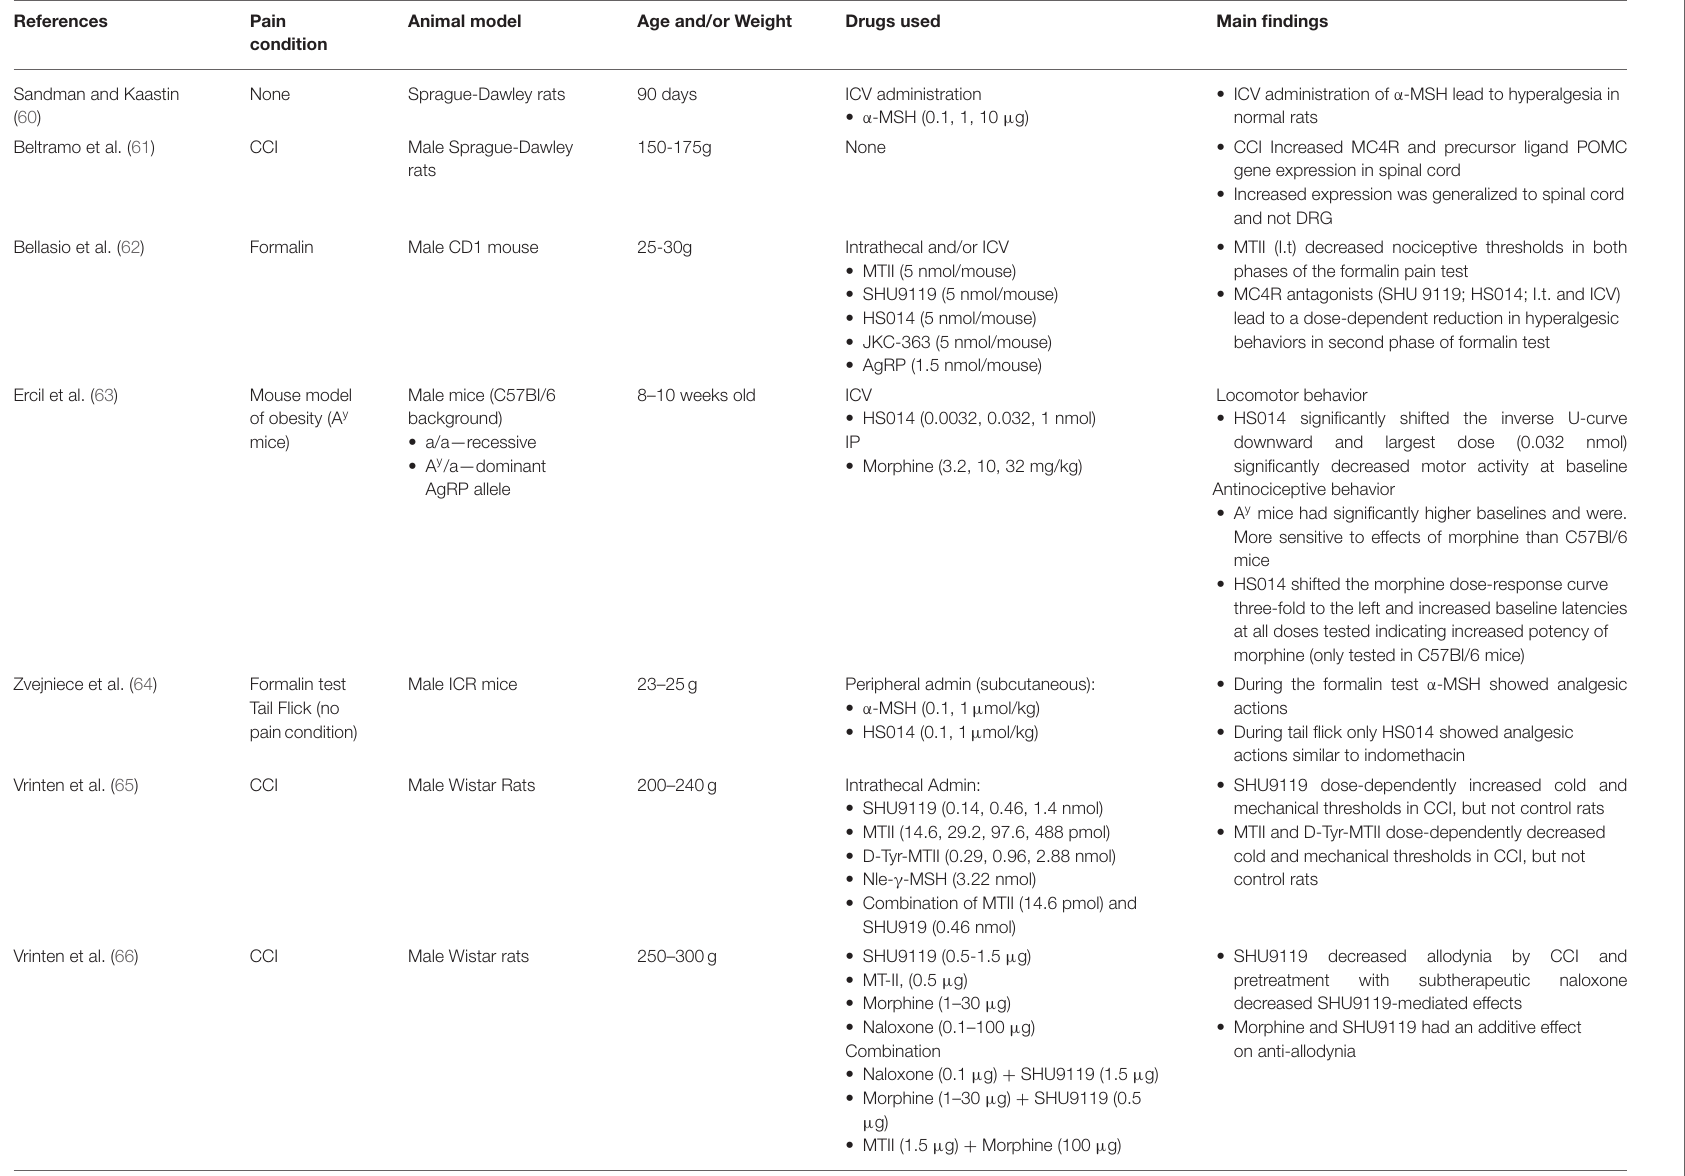
TABLE 1 | Melanocortin system interactions on pain-related